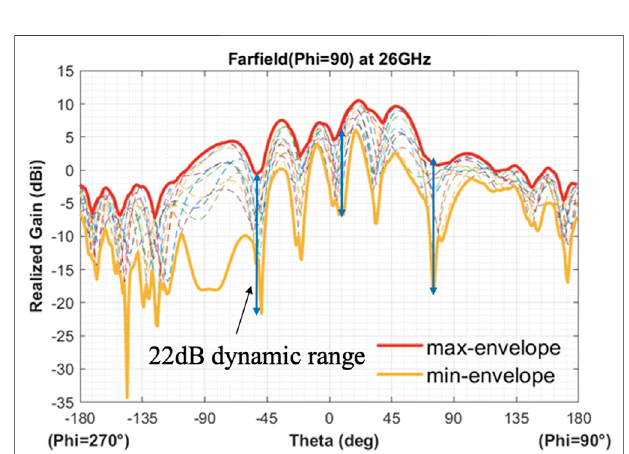
FIGURE 5 | The radiation envelopes of the surface wave fl uid antenna at different fl uid positions at 26 GHz.